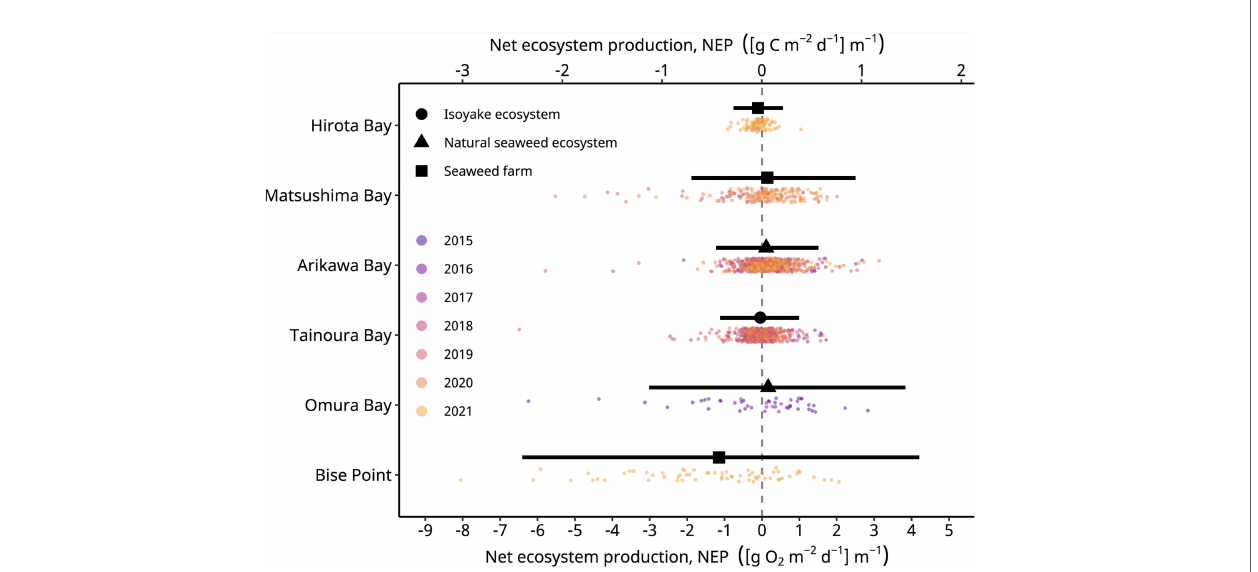
FIGURE 2 | The observed (colored points) and conditional mean of the net ecosystem production (black symbols) rates of the study sites. The black horizontal lines indicate the 95% highest density credible interval of the predicted values. Hirota Bay and Matsushima Bay are the Undaria pinnati fi da aquaculture farms, Bise Point is the Cladosiphon okamuranus aquaculture farm, Arikawa Bay and Omura Bay are sites of the natural Sargassum spp. ecosystem, and Tainoura Bay is a site where a seaweed ecosystem has degraded into an isoyake state. The net ecosystem production in O 2 and C are calculated assuming a 1 to 1 molar